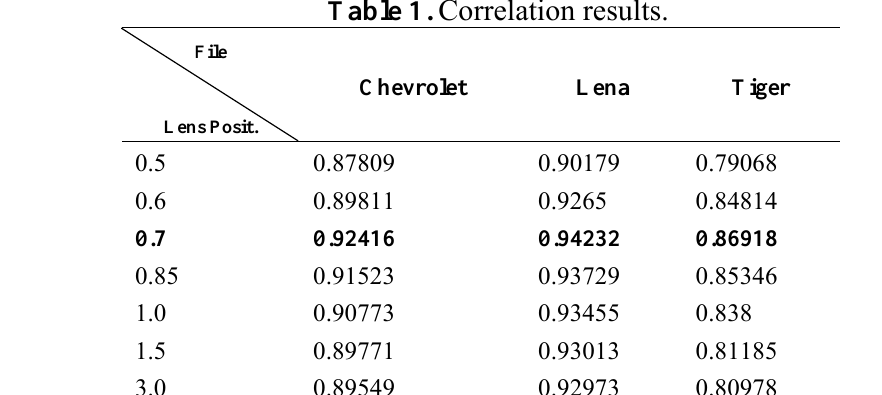
Table 1. Correlation